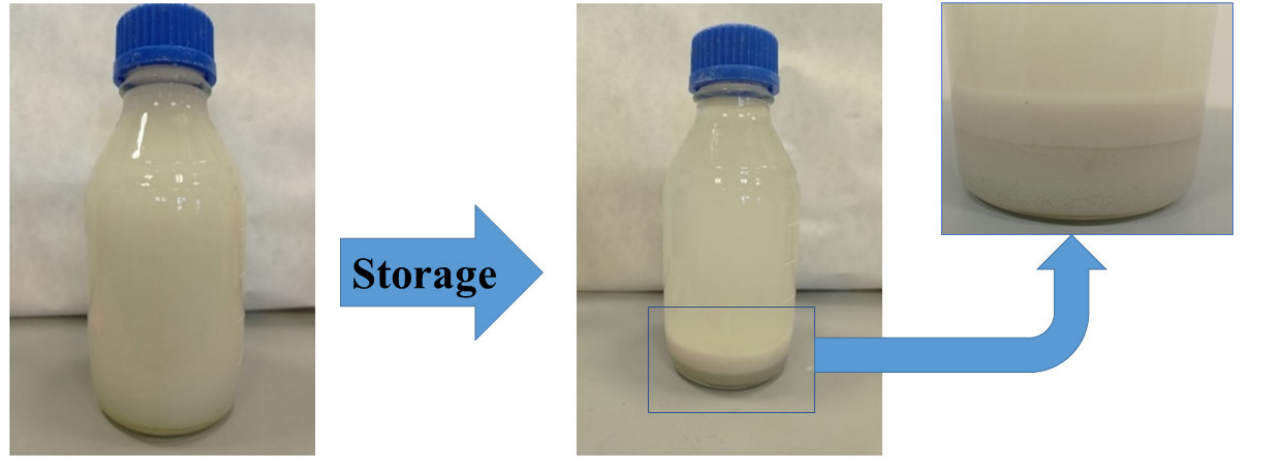
Figure 5. Waste phosphate immediately after mixing with compressed air ( left ) and after one day of storage ( right ).